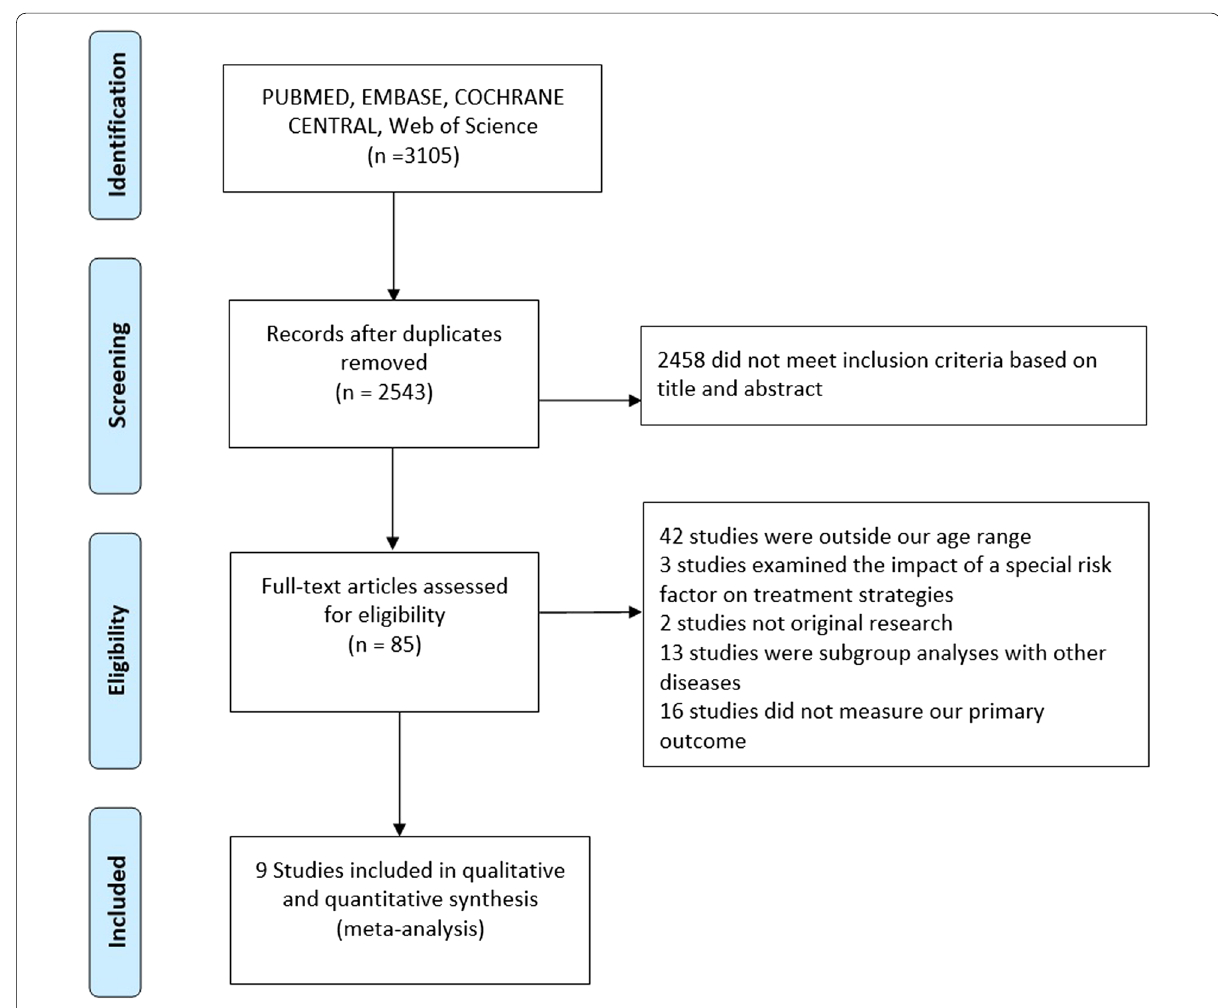
Fig. 1 Flowchart of selected